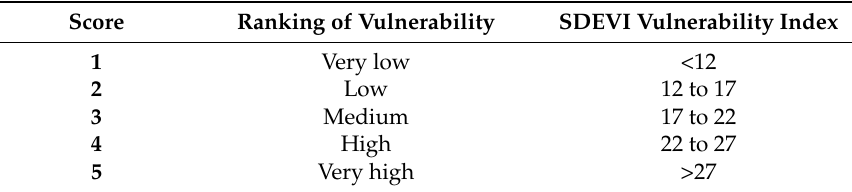
Table 1. Sand dune encroachment vulnerability according to the Sand Dune Encroachment Vulnerability Index (SDEVI)